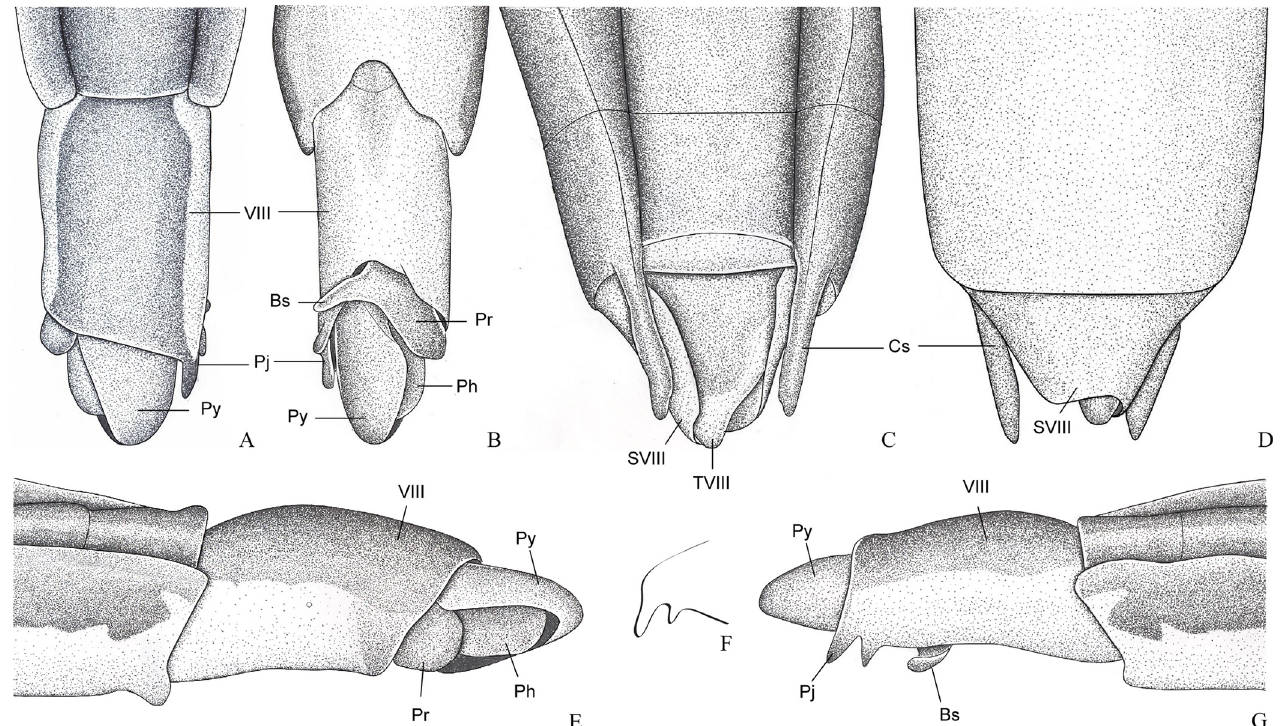
Fig 1. Potamobates anchicaya . (A) Male, terminalia, dorsal view; (B) male, terminalia, ventral view; (C) female, terminalia, dorsal view; (D) female, terminalia, vista ventral; (E) male, terminalia, left lateral view; (F) variation of projection VIII; (G) male, terminalia, right lateral view. VIII : segment VIII; BS : Processo basolateral of proctiger; PR: Proctiger; PH : Phallus; PY: Pigophore; PJ: Projection of segment VIII; CS : Connexival spine; SVIII : Sternun VIII. 3– Projection of male last abdominal laterotergite (= connexival spine) with acute apex; posterior margin of female abdominal sternum VII without projections . . . Cylindrostethus 3’–Projection of male last abdominal laterotergite (= connexival spine) with rounded apex (Fig 6A); posterior margin of female abdominal sternum VII with a pair of lateral projections (Fig 6A) . . . . Brailovskybates Floriano and Moreira, gen. nov. Potamobates Champion 1898